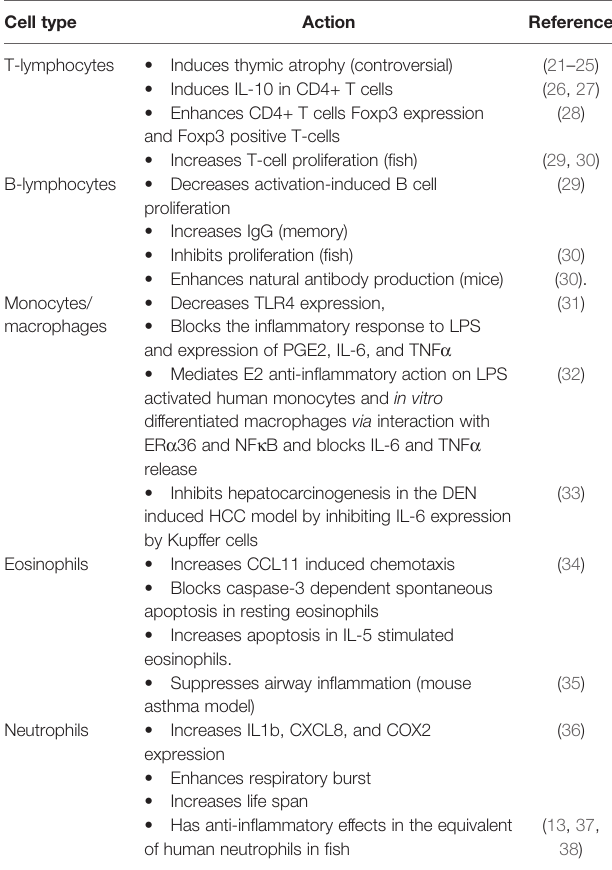
TABLE 1 | Actions attributed to GPER1 in each cell type of the immune